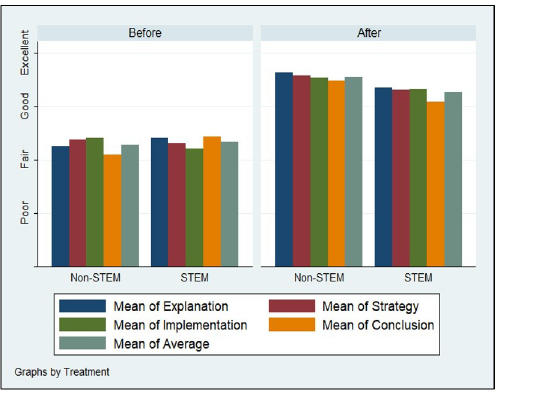
Table 5. Simple means’ comparison.